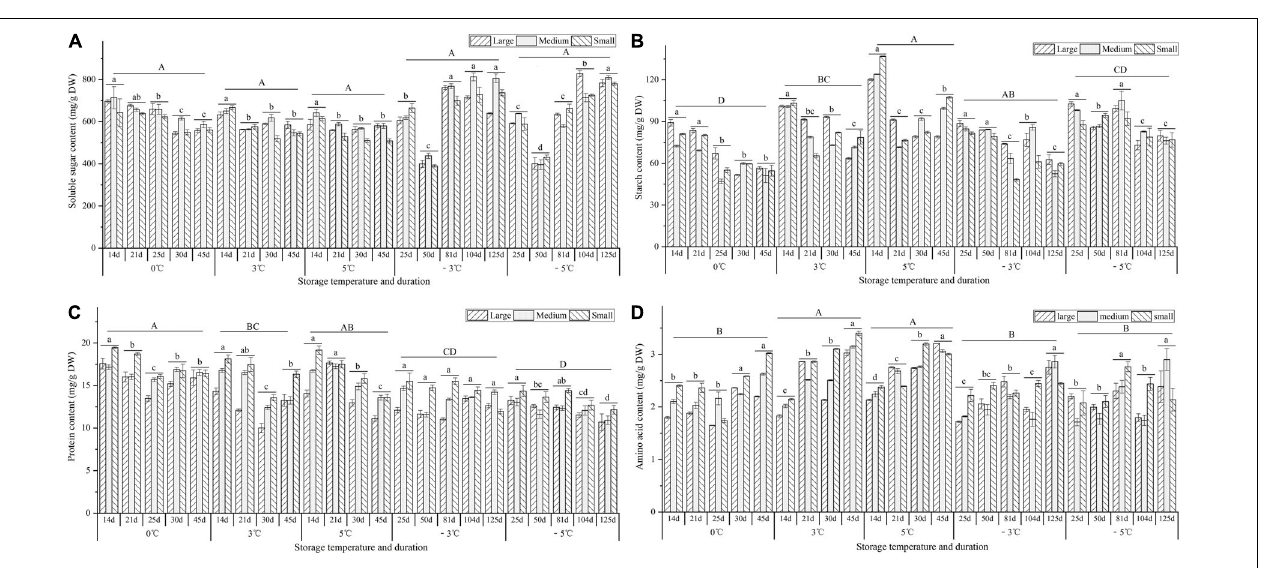
FIGURE 8 | Changes in the contents of soluble sugar, starch, protein, and amino acid of seedlings at different storage temperatures and durations. Panels (A–D) represent the contents of soluble sugar, starch, protein, and amino acid, respectively. n = 10 per stage for the different size seedlings. Different uppercase letters represent a significant difference ( P < 0.05) in the average value of different seedlings and storage durations among different temperatures. Different lowercase letters represent a significant difference in the average value of different seedlings between the storage durations for the same